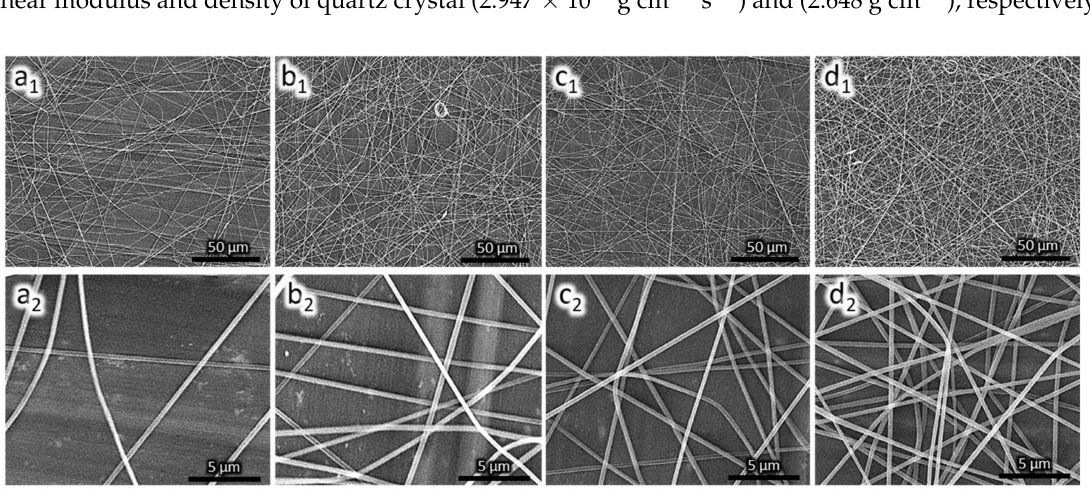
Figure 3. SEM image of PAN nanofiber on QCM surface; ( a ) PAN-NF 1; ( b ) PAN-NF 2; ( c ) PAN-NF 3; and ( d ) PAN-NF 4.